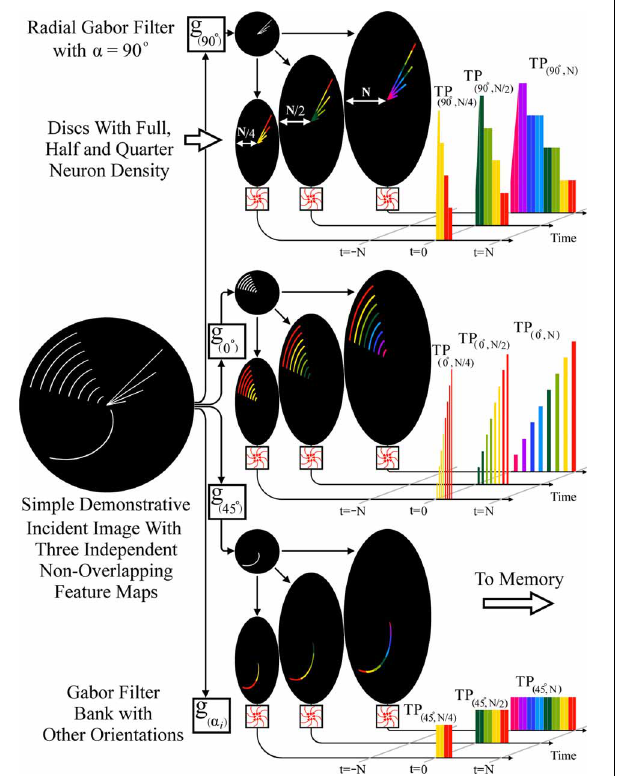
FIGURE 8 | RPN producing a spatiotemporal pattern using parallel radial Gabor filters and discs with varying neuron densities. The incident image is processed by a filter bank of radial Gabor filters generating multiple feature maps (3 shown) each of these is then projected onto three discs with N (full), N /2 (half), and N /4 (quarter) density. The lower density discs simply generate an earlier low resolution version of the full TP which can be used by the memory for normalization or early categorization. The nine TPs shown illustrate the multiplicative effect of feature extractors when combined in a fan-out fashion.